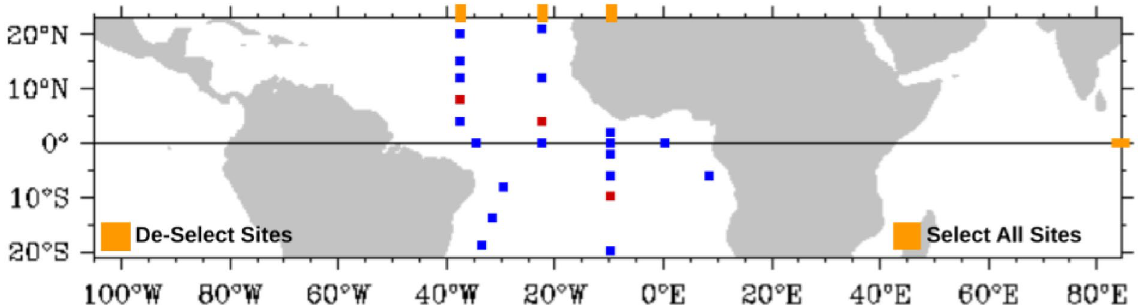
Figure 2. Buoys locations of the PIRATA project in the Atlantic Ocean. Font: https:// www. pmel. noaa. gov/ tao/ drupal/